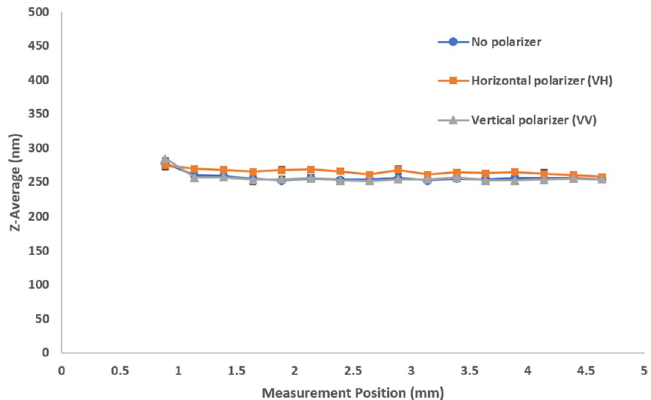
Figure 6. Size (z-average diameter) as a function of measurement position shows the absence of multiple scattering with different polarizer configurations for 1000-fold diluted milk. The sample shows single scattering with consistent sizes over position regardless of polarizer configuration.